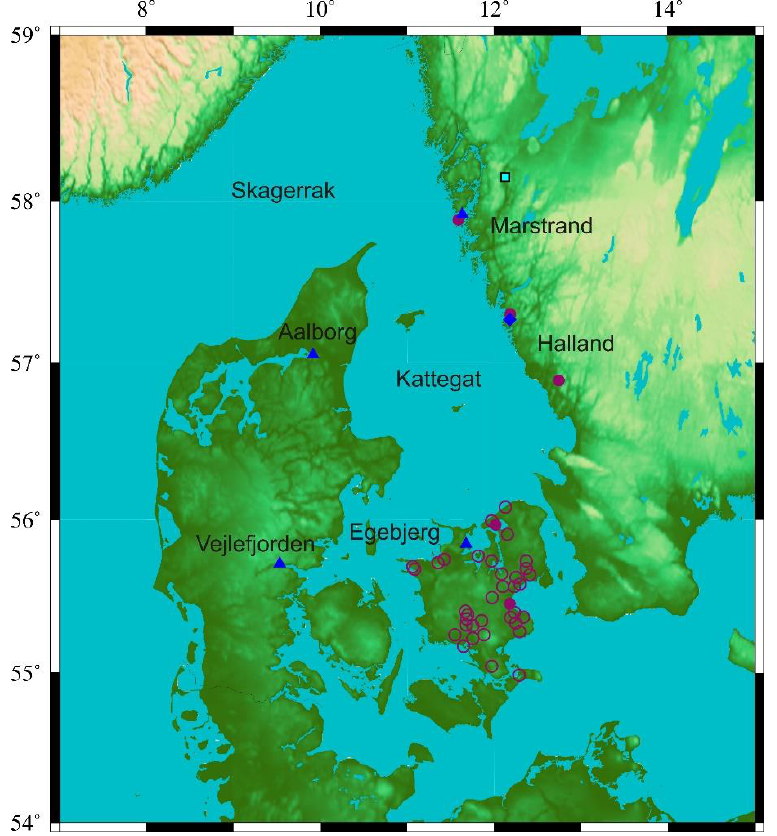
Figure 3. Earthquake environmental effects related to the Kattegat earthquake on 21 December 1759 (the filled purple circles denote water movements, the open circles denote sites with reportedly calm water, the blue triangles denote cracked ice, and the square denote landslides).